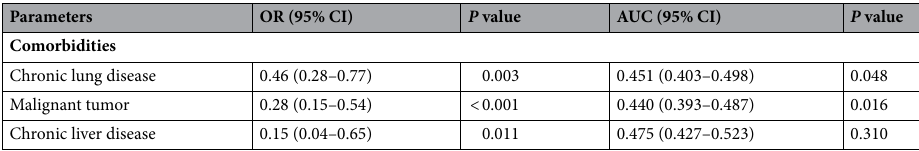
Table 3. Univariate analyses and area under receiver operating characteristic curve of comorbidities to distinguish between COVID-19 positive and negative tested